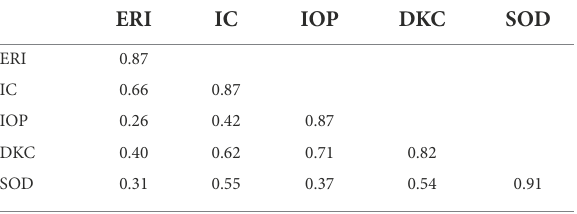
TABLE 3 Discriminant validity test (Fornell and Larcker criterion).